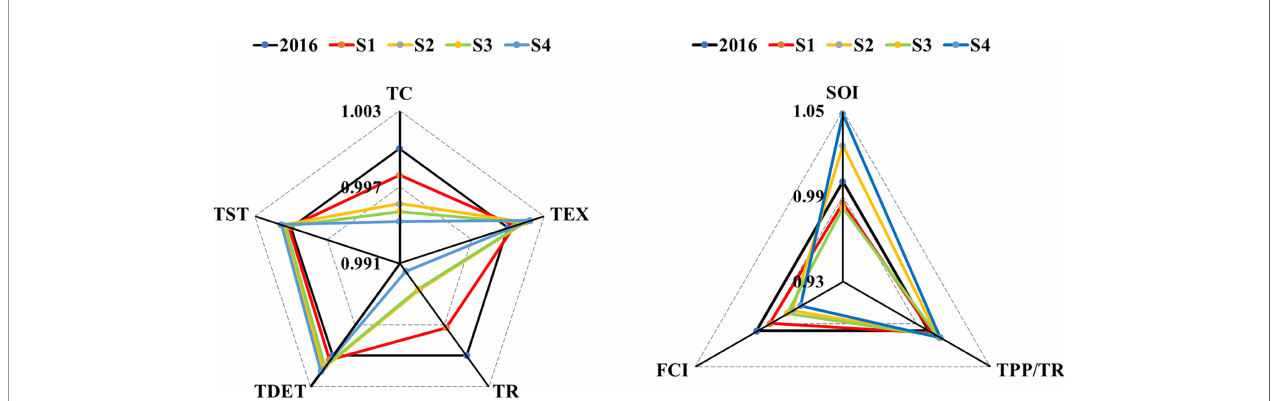
FIGURE 6 | Variations of characteristic indicators of the Minjiang Estuary ecosystem under four scenarios. Left: indicators re fl ecting the overall size, maturity, and stability of an ecosystem, including total system throughput (TST), total export (TEX), total respiration fl ows (TR), total fl ow into detritus (TDET), and total consumption (TC); right: indicators re fl ecting the complex relationships within an ecosystem and the maturity of an ecosystem, including system omnivory index (SOI), total primary production/total biomass (TPP/TR), and Finn ’ s cycling index